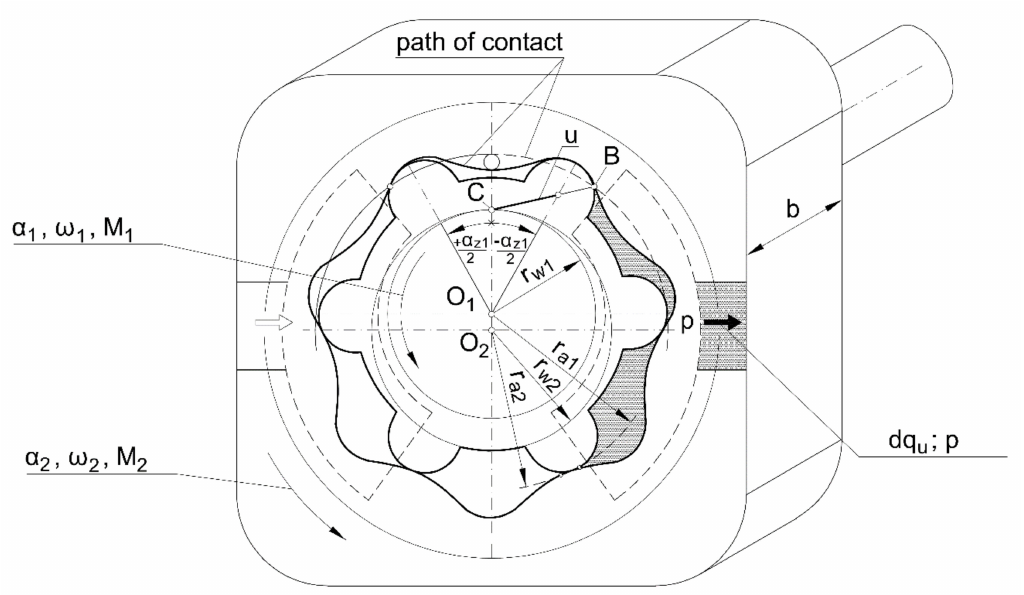
Figure 10. Model of a gerotor machine with hypocycloidal